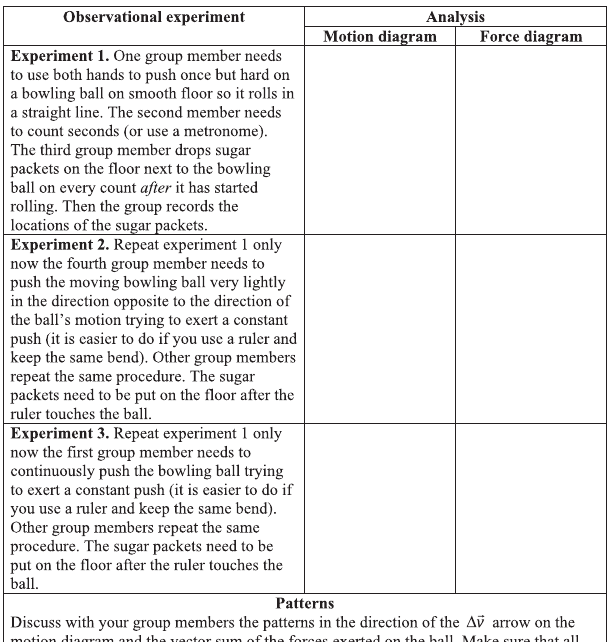
FIG. 7. Activity 3.3.1 from the active learning guide. Obser- vational experiment to find the relationship between the force diagram and motion diagram